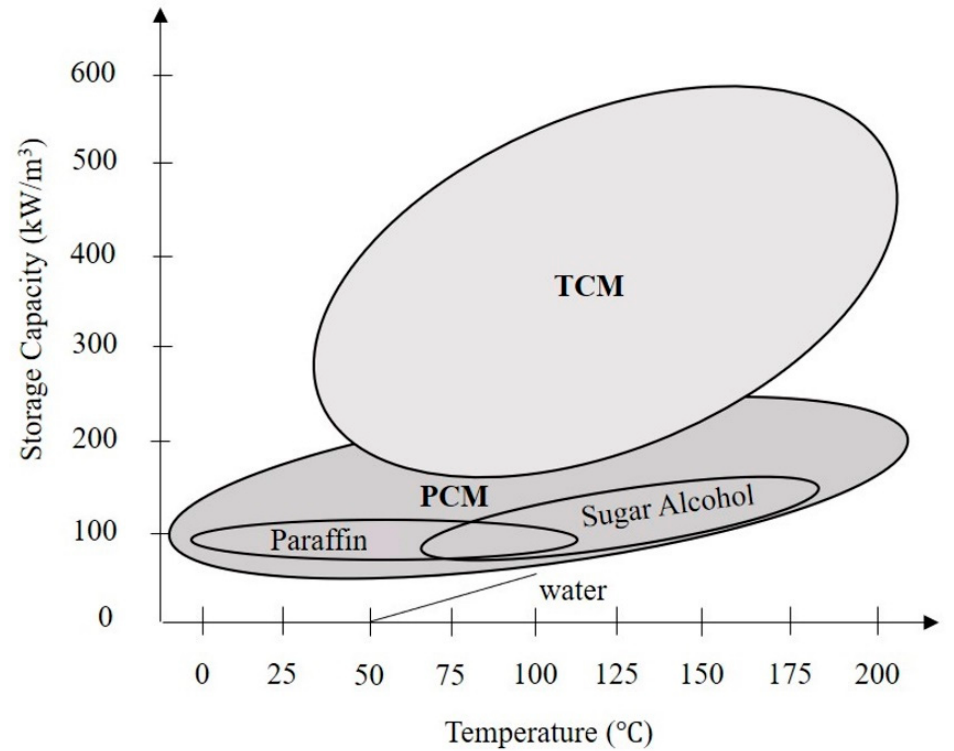
Figure 2. Stored heat energy vs. temperature range used to change the phases.